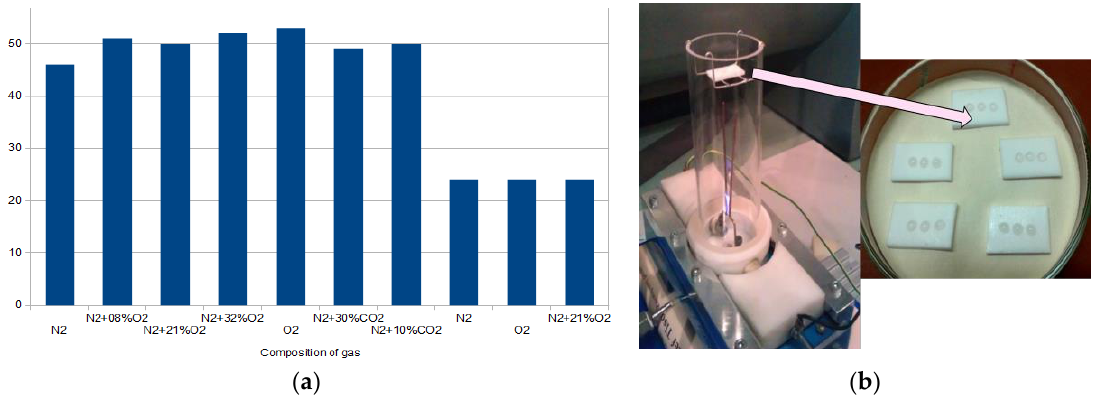
Figure 16. ( a ) Final temperature in degrees centigrade on the surface of the sample in function of gas composition—N 2 , O 2 , and CO 2 and their mixtures—, ( b ) E-coli bacteria samples treated by µ GADs, distance between the top of electrodes and the sample 21 mm [59].